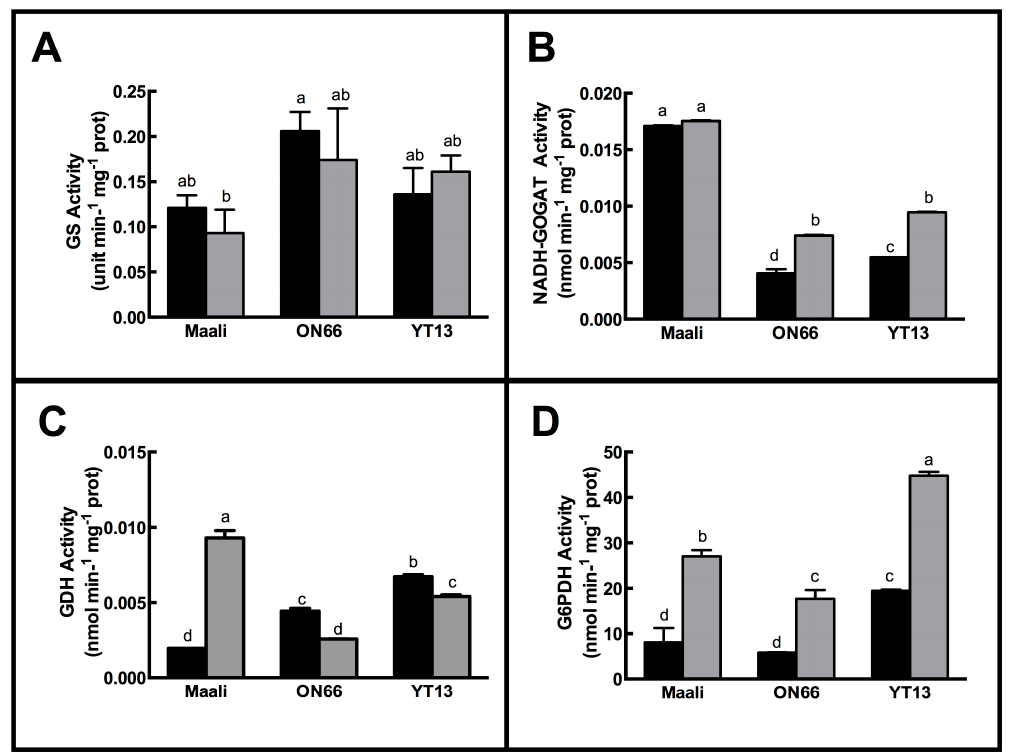
Figure 2. Changes in the activities of GS ( A ), GOGAT ( B ), GDH ( C ), and G6PDH ( D ) in durum wheat leaves. Enzymatic rates in control plants are in black bars; activities in stressed plants are in grey bars. Data are the average of at least three determinations ± standard error. Letters indicate homogenous data.